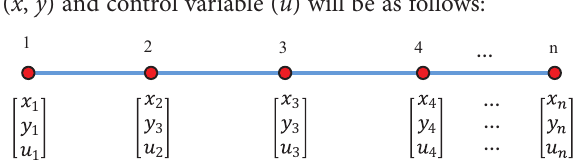
Figure 1. Schematic of the discretized trajectory with state and control